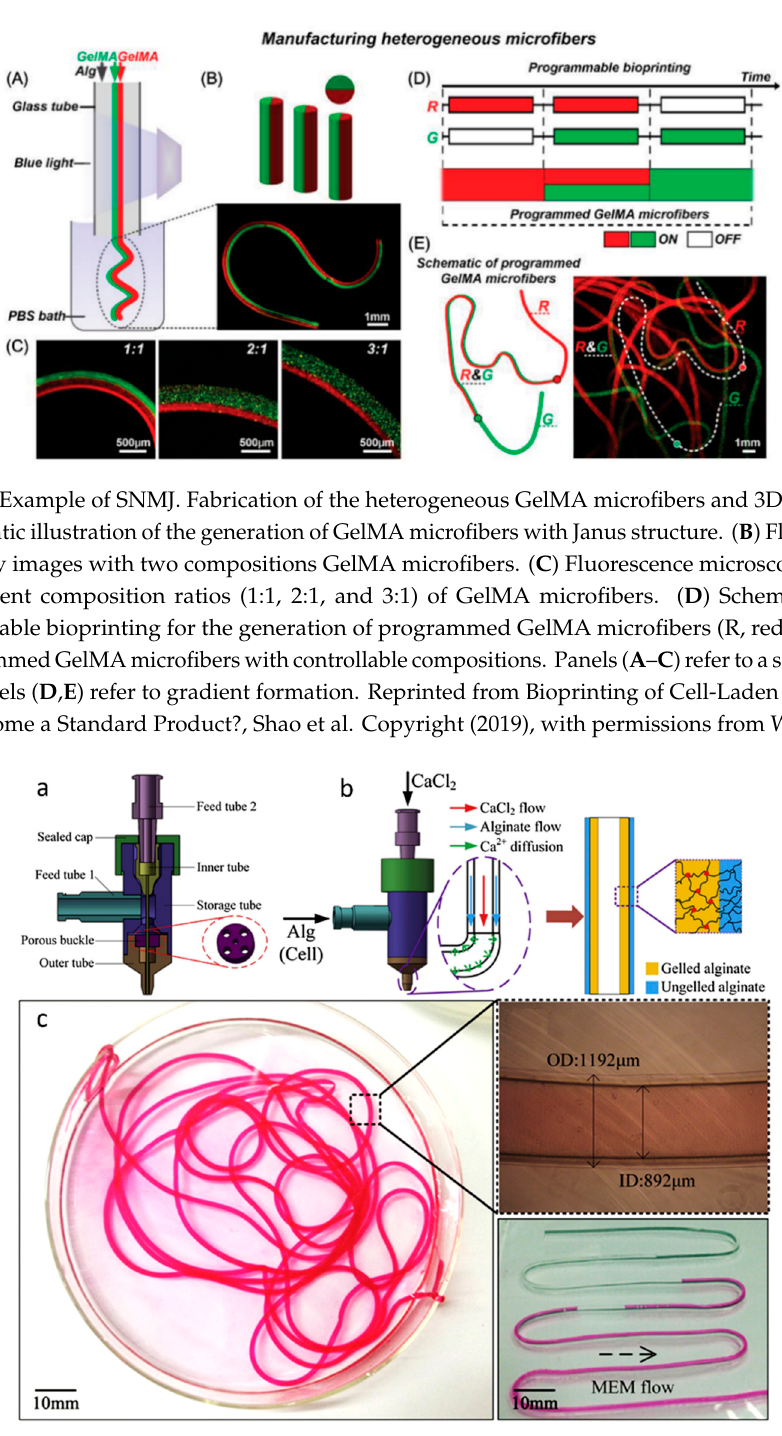
Figure 16. Example of INMJ. ( a ) Cross-section of a co-axial nozzle assembly model. ( b ) Schematic of the fabrication of the hollow filament ( c ) photography of a printed alginate hollow filaments (left) and inverted microscopic image of the hollow filaments (top right). Perfusion of the filament with cell culture media (bottom right). Reprinted from Coaxial nozzle-assisted 3D bioprinting with built-in microchannels for nutrients delivery, showing a co-axial needle allowing to print hollow filament using a core–shell concept. Gao et al. Copyright (2015), with permission from Elsevier [94].